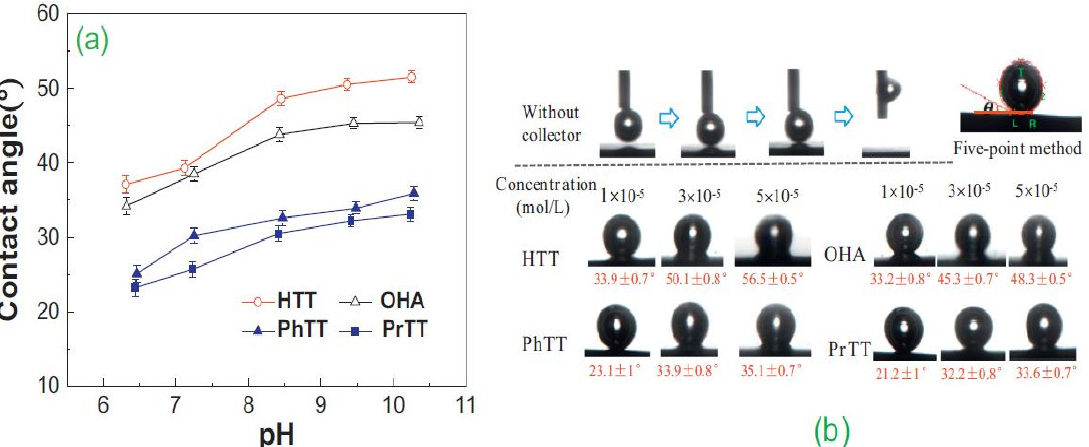
Figure 14. ( a ) Relationship between the collector dosage and the recovery of fine-grained malachite. Distribution of malachite particles under the microscope ( b ) before and ( c ) after adding ZH-1 [91].